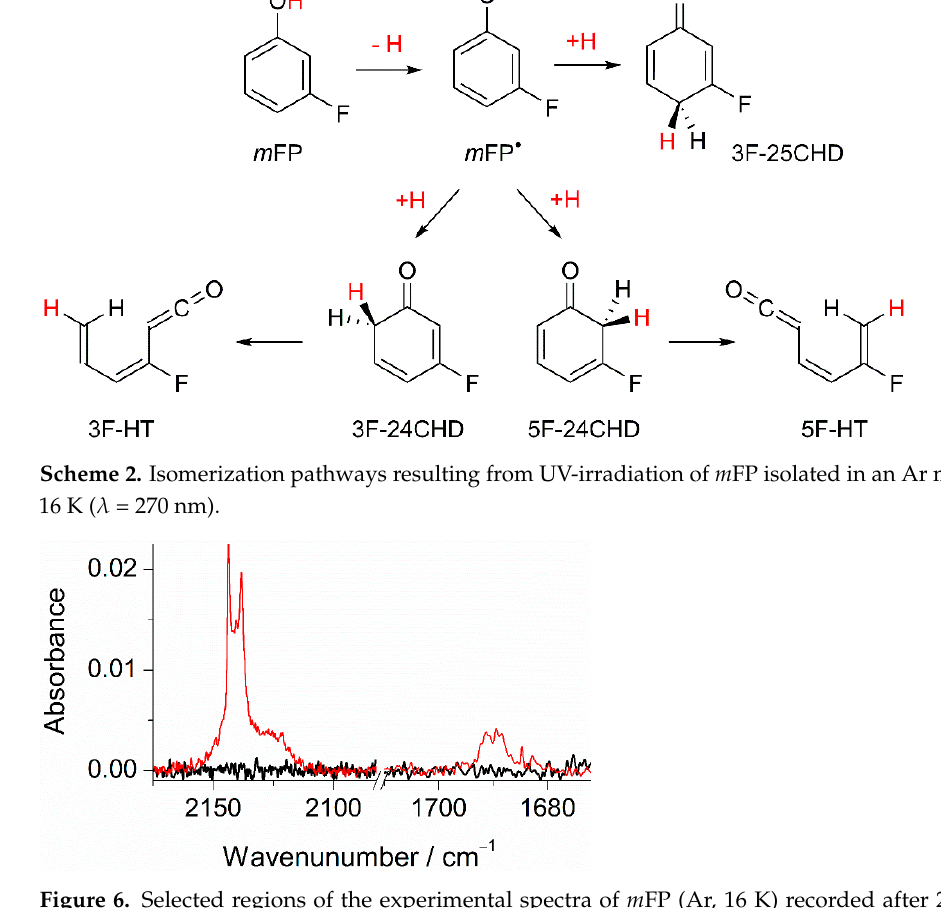
UV irradiations. However, no such bands were observed, indicating that under the pre- sent experimental conditions, decarbonylation of fluorinated cyclohexadienones does not occur. Thus, the doublet band at 2144/2138 cm − 1 is only attributed to open-ring ketenes 3-fluorohexa-1,3,5-trien-1-one (3F-HT) or 5-fluorohexa-1,3,5-trien-1-one (5F-HT), see Scheme 2. The wavenumbers (scaled) corresponding to the C=C=O antisymmetric